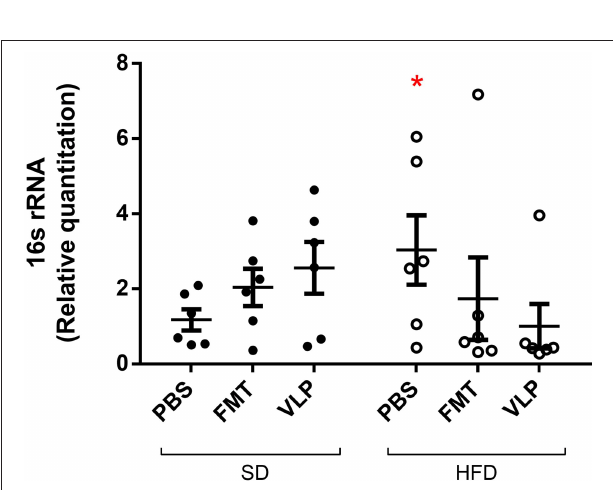
FIGURE 4 | Mean weight change for each group over the course of the experiment represented in grams.